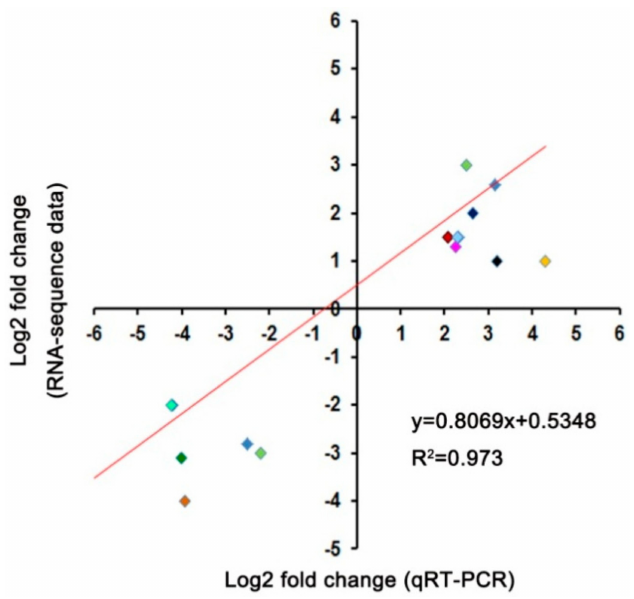
Figure 5. qRT-PCR validation of differentially expressed genes under drought stress. Correlation between the fold change analyzed by RNA-seq ( x -axis) and data obtained using qRT-PCR. The different colors represent different genes